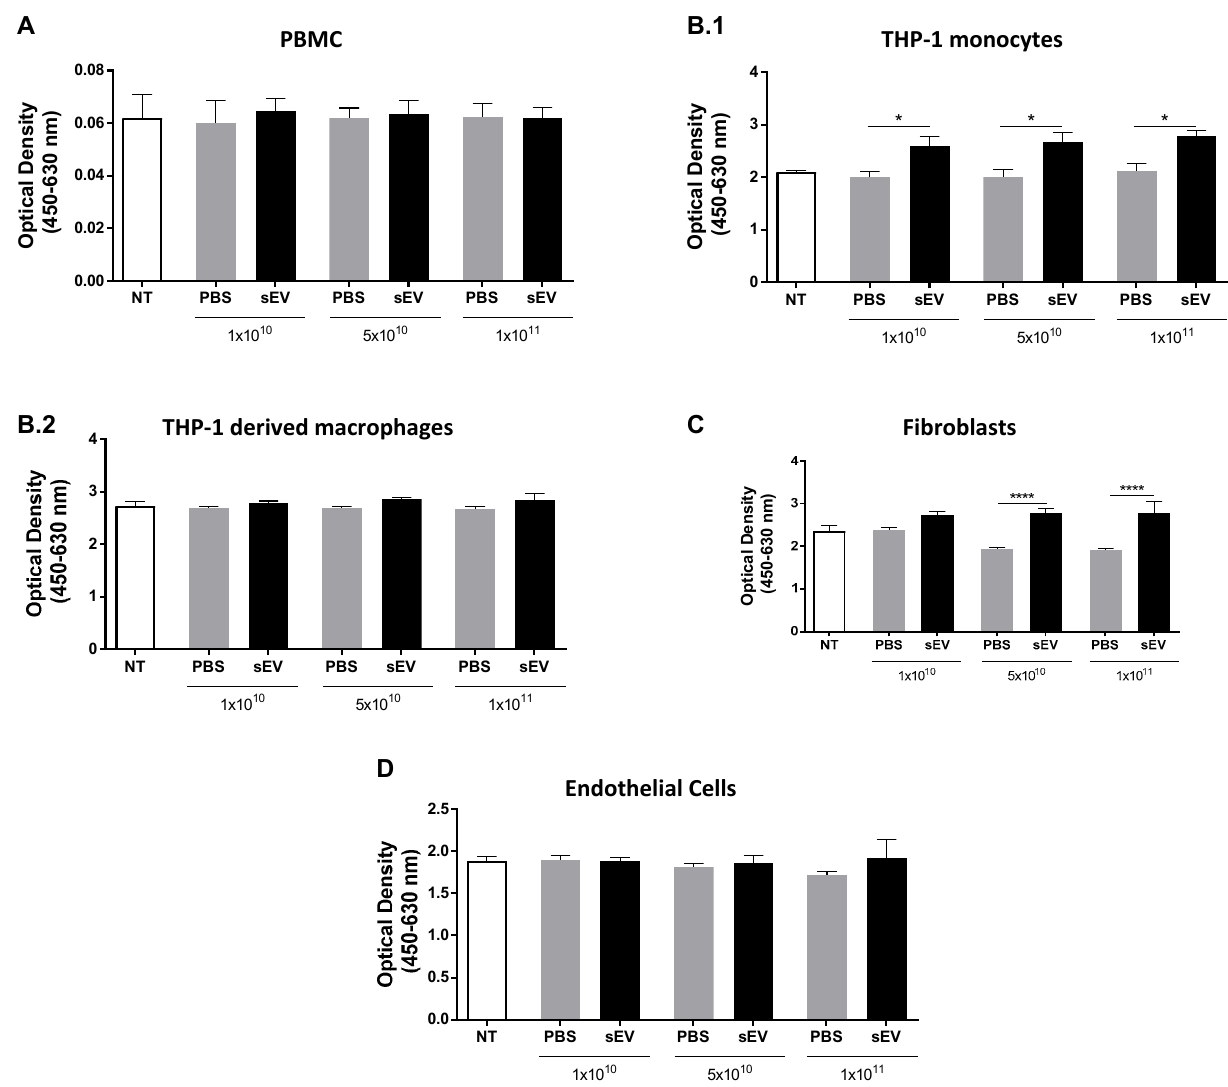
Figure 1. UCB-MNC-sEV do not induce cytotoxic effects in vitro. After cell seeding, cells received six doses of UCB-MNC- sEV, with the indicated particle concentration. After a 72 h treatment, cellular metabolic activity was measured by an XTT assay on ( A ) PBMC (n ≥ 3 per condition), ( B.1 ) THP-1 monocytes (n ≥ 3 per condition), ( B.2 ) THP-1 derived macrophages (n ≥ 3 per condition), ( C ) fibroblasts (n ≥ 6 per condition), and ( D ) endothelial cells (n ≥ 6 per condition). NT refers to “not treated” conditions. Results are presented as mean ± SEM. Statistical analyses were performed by ANOVA, * for p value < 0.05, and **** for p value < 0.0001. If not otherwise marked, no statistical difference was found between PBS ‐ and sEV ‐ treated cells.